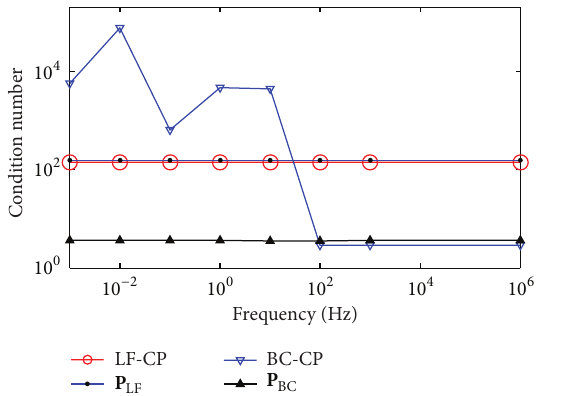
Figure 7: The condition numbers of the coupling matrices and the corresponding Gram matrices.